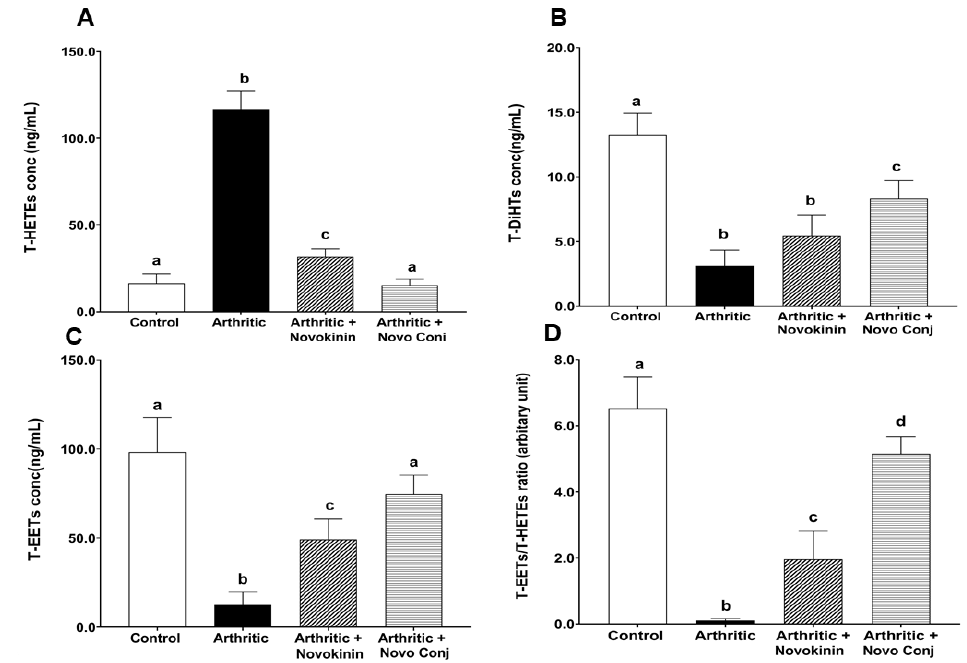
Figure 8. Impact of novokinin and novokinin conjugate (Novo Conj) treatment on total-HETEs (T-HETEs) ( A ), Total-DiHTs (T-DiHTs) ( B ), Total-EETs (T-EETs) ( C ), and the ratio of T-EETs/T-HETEs ( D ) arthritic rats plasma. Mean ± SD ( n = 5 or 6). Data labeled with different letters (a, b, c, or d) indicate a statistical difference between groups where p < 0.05.